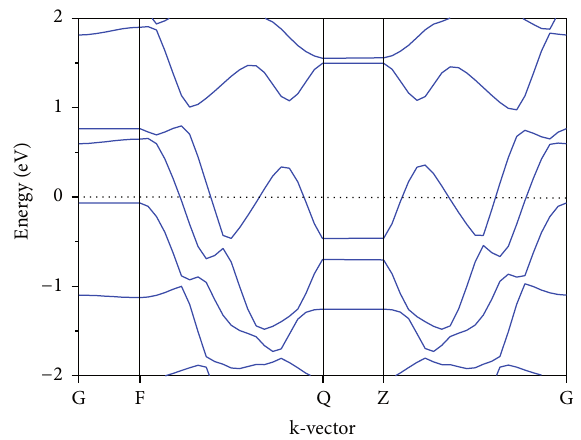
Figure 3: The electronic band structure of N1-doped single walled armchair (3,3) BNT. The Fermi level is set corresponding to zero energy and represented by dotted line.